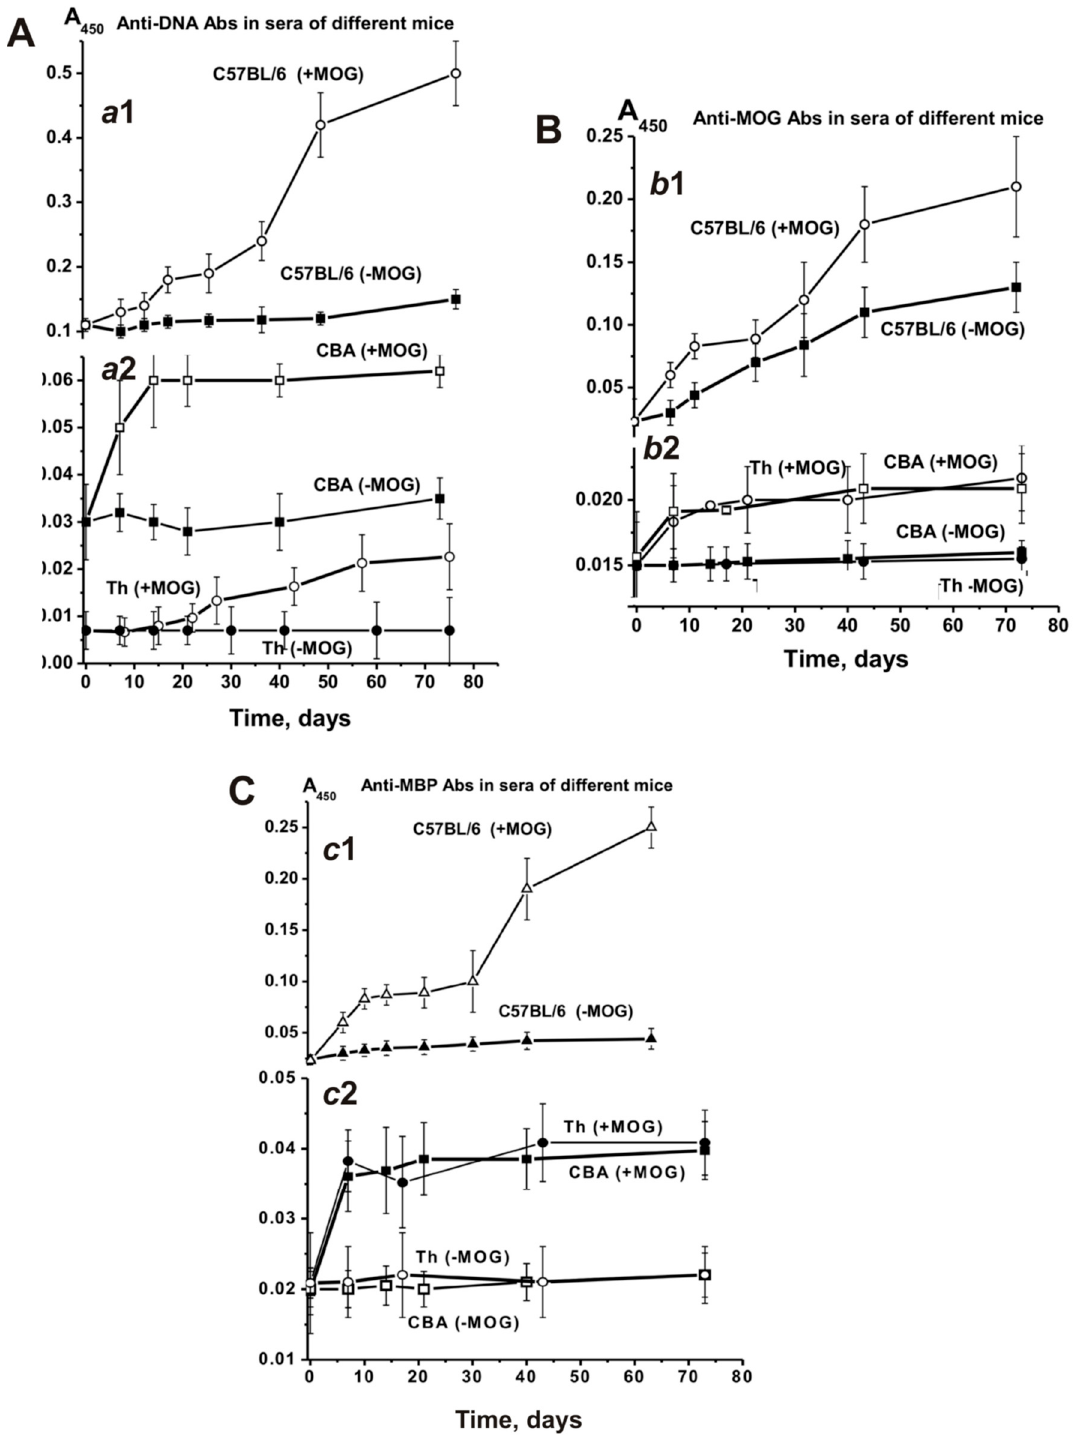
Figure 7. Relative changes over time in anti-DNA ( A ; a1 and a2), anti-MOG ( B ; b1 and b2), and anti-MBP ( C ; c1 and c2) concentrations characterizing EAE-prone C57BL / 6, CBA, and Th mice before and after their immunization with MOG. The relative concentration was estimated for each mouse and all groups (with seven mice per group); the error from three independent experiments did not exceed